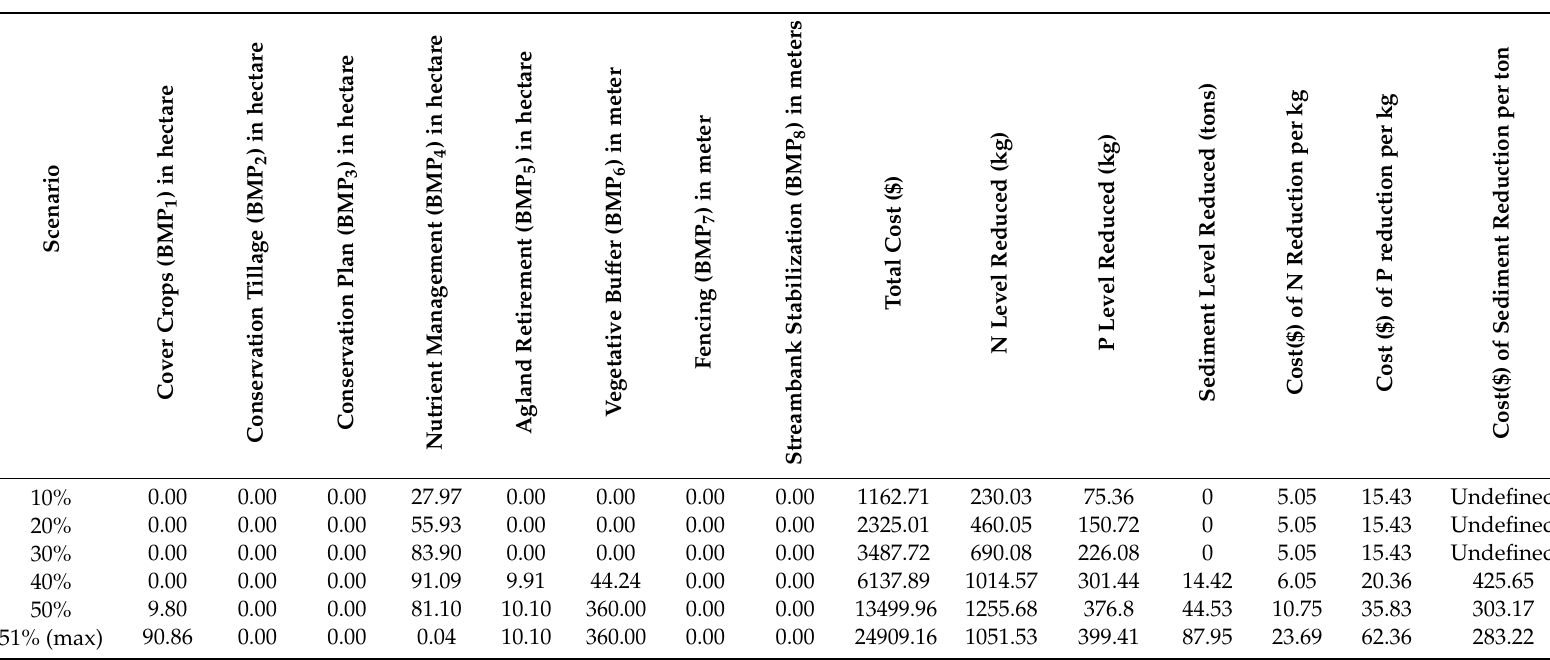
Table 5. Summary of BMP adopted area, total cost of pollutant reduction, and unit cost of nitrogen, phosphorus, and sediment reductions under alternative weather scenarios in the Saline Bayou watershed (wet year